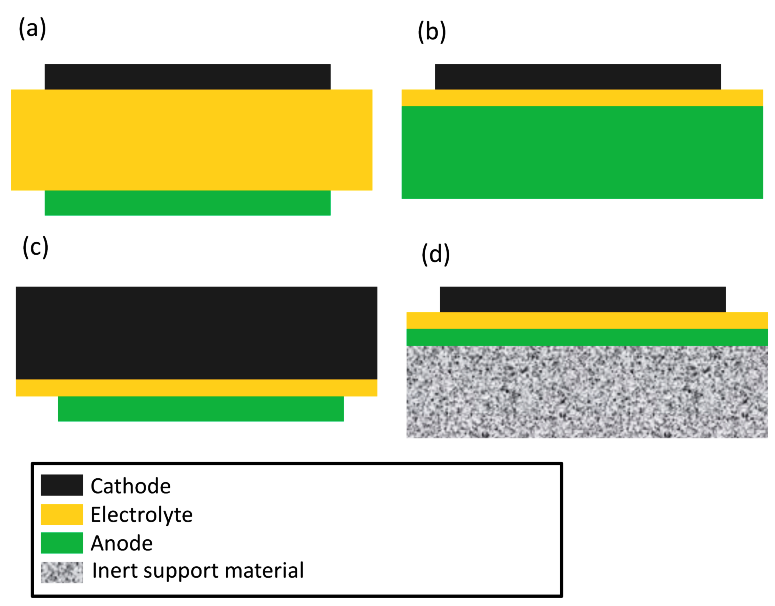
Figure 4. Different types of fuel cell design: ( a ) electrolyte; ( b ) anode; ( c ) cathode and ( d ) metal or ceramic supported [8].